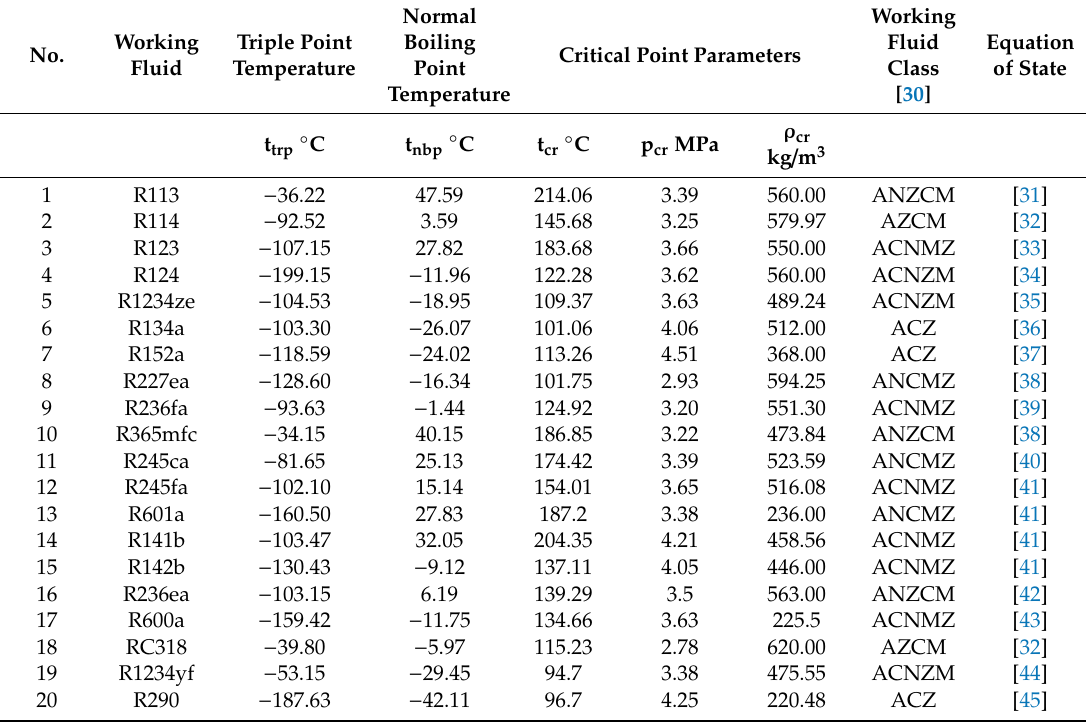
Table 2. The working fluids suitable for small- and low-power Organic Rankine Cycle (ORC) systems with volumetric expanders